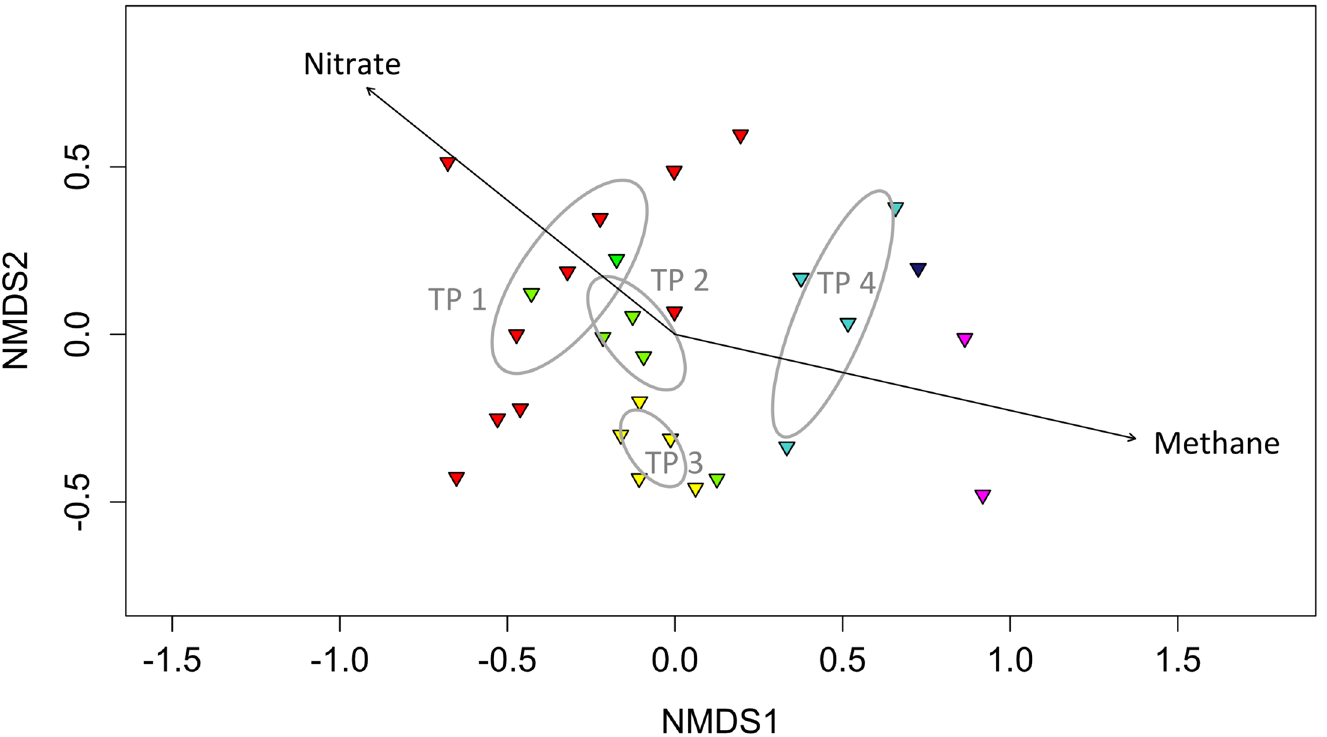
Fig 3. NMDS plot (stress 0.13) of 16S rRNA bacterial DGGE banding patterns. Arrows indicate the direction triggered by methane and nitrate as the strongest analyzed environmental factors. Ellipses indicate a confidence interval of 95% and ANOSIM analysis was significant (p = 0.001, r = 0.558). Colors indicate the six transitions phases (TP): red = TP 1 (Transition from oxygen to nitrate as electron acceptor), green = TP 2 (Short oxic pulse), yellow = TP 3 (nitrate depletion and sulfide development), light blue = TP 4 (Nitrate additions under sulfidic condition), dark blue = sulfidic phase, purple = oxic phase.